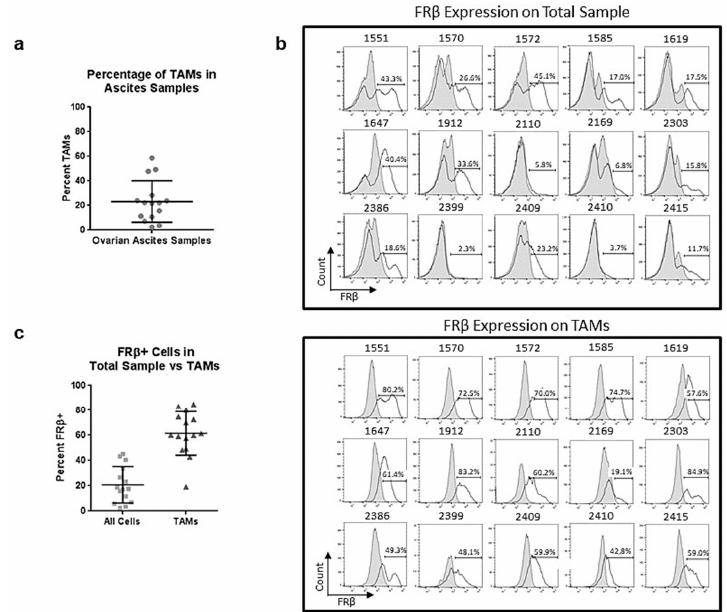
Figure 6. Tumor associated macrophages in ovarian cancer ascites samples and expression of FR β . ( a ) Percentage of TAMs making up each of the fifteen ovarian ascites samples as determined by CD11b and CD14 double-positive population with an average of 23.3%. ( b ) Flow plots showing the expression of FR β in each of the 15 total ascites samples compared to expression on TAMs in the sample. ( c ) Comparison of the average expression of FR β in the total sample (20.8%) versus expression on TAMs (61.6%). Int. J. Mol. Sci. 2021 , 22 , x FOR PEER REVIEW